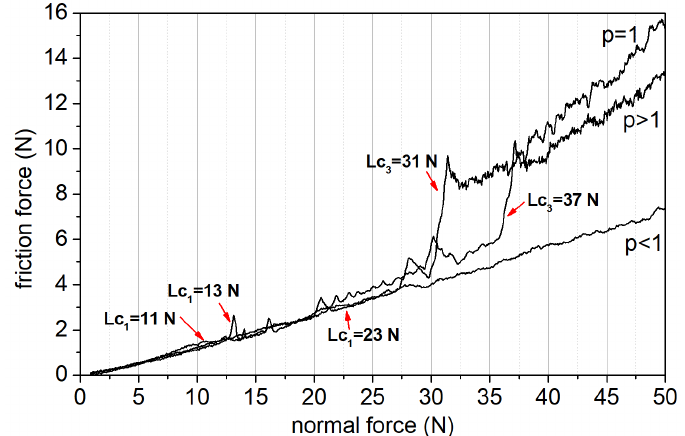
Figure 10. Frictional force versus normal force for selected prototypes— p > 1, p = 1, p < 1. Microscopic photos of scratch path, illustrating damages of coatings for the L c1 and L c3 critical loads are presented in Figure 11a‒f.